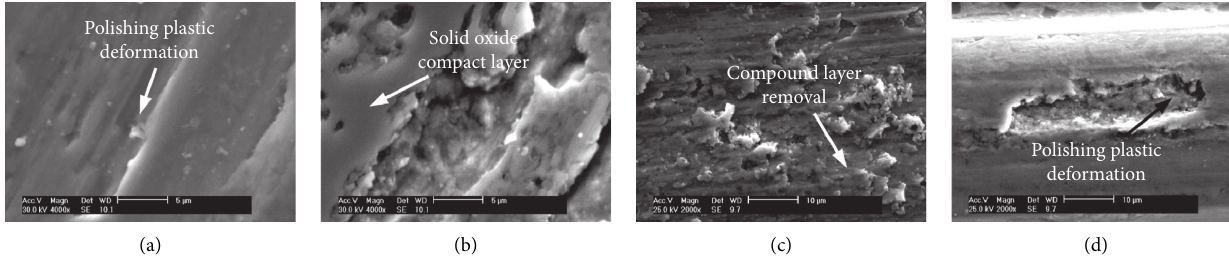
Figure 20: Worn morphologies of S0 and S2 coatings at room temperature and 700 ° C: (a) polishing plastic deformation in S0 coating at room temperature; (b) solid oxide compact layer in S0 coating at 700 ° C; (c) compound layer removal in S2 coating at room temperature; (d) pitting corrosion in S2 coating at 700 °